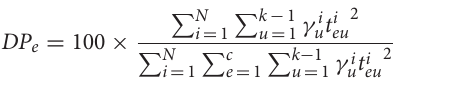
Frontiers in Human Neuroscience |